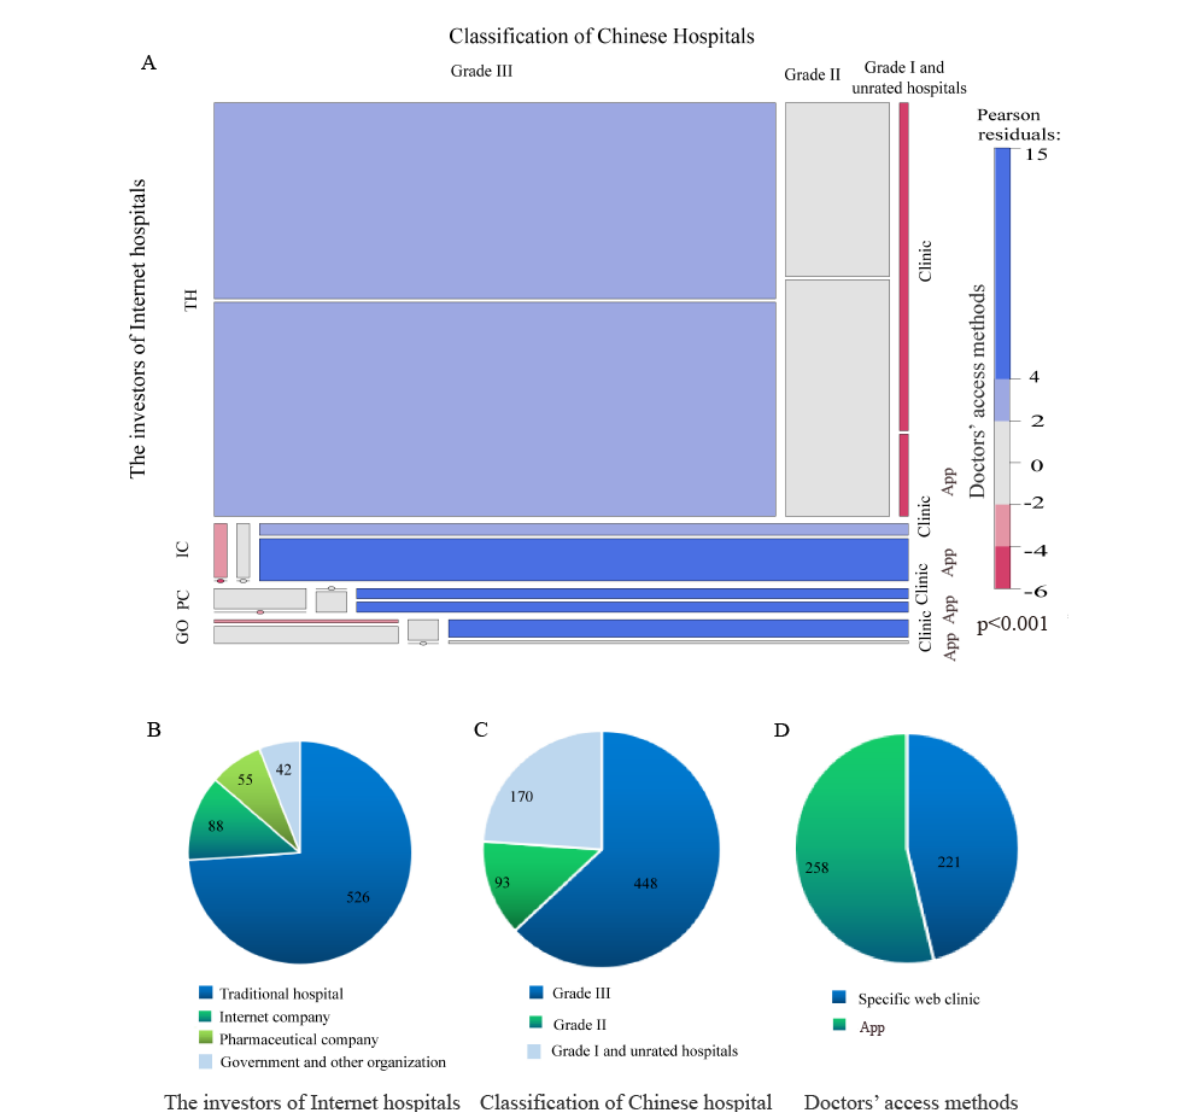
Figure 4. Characteristics of internet hospitals. (A) A mosaic plot with areas that show the proportion of doctors’ web-based methods for accessing internet hospitals in China, stratified by the classification of Chinese hospitals and the structure of the main investment. The investors of internet hospitals include THs, ICs, PCs, and GOs. The classification of Chinese hospitals were as follows: Grade III, Grade II, and Grade I and unrated hospitals. Doctors provided medical services through a specific web clinic or app. (B) The investors of internet hospitals. (C) Classification of Chinese hospitals.